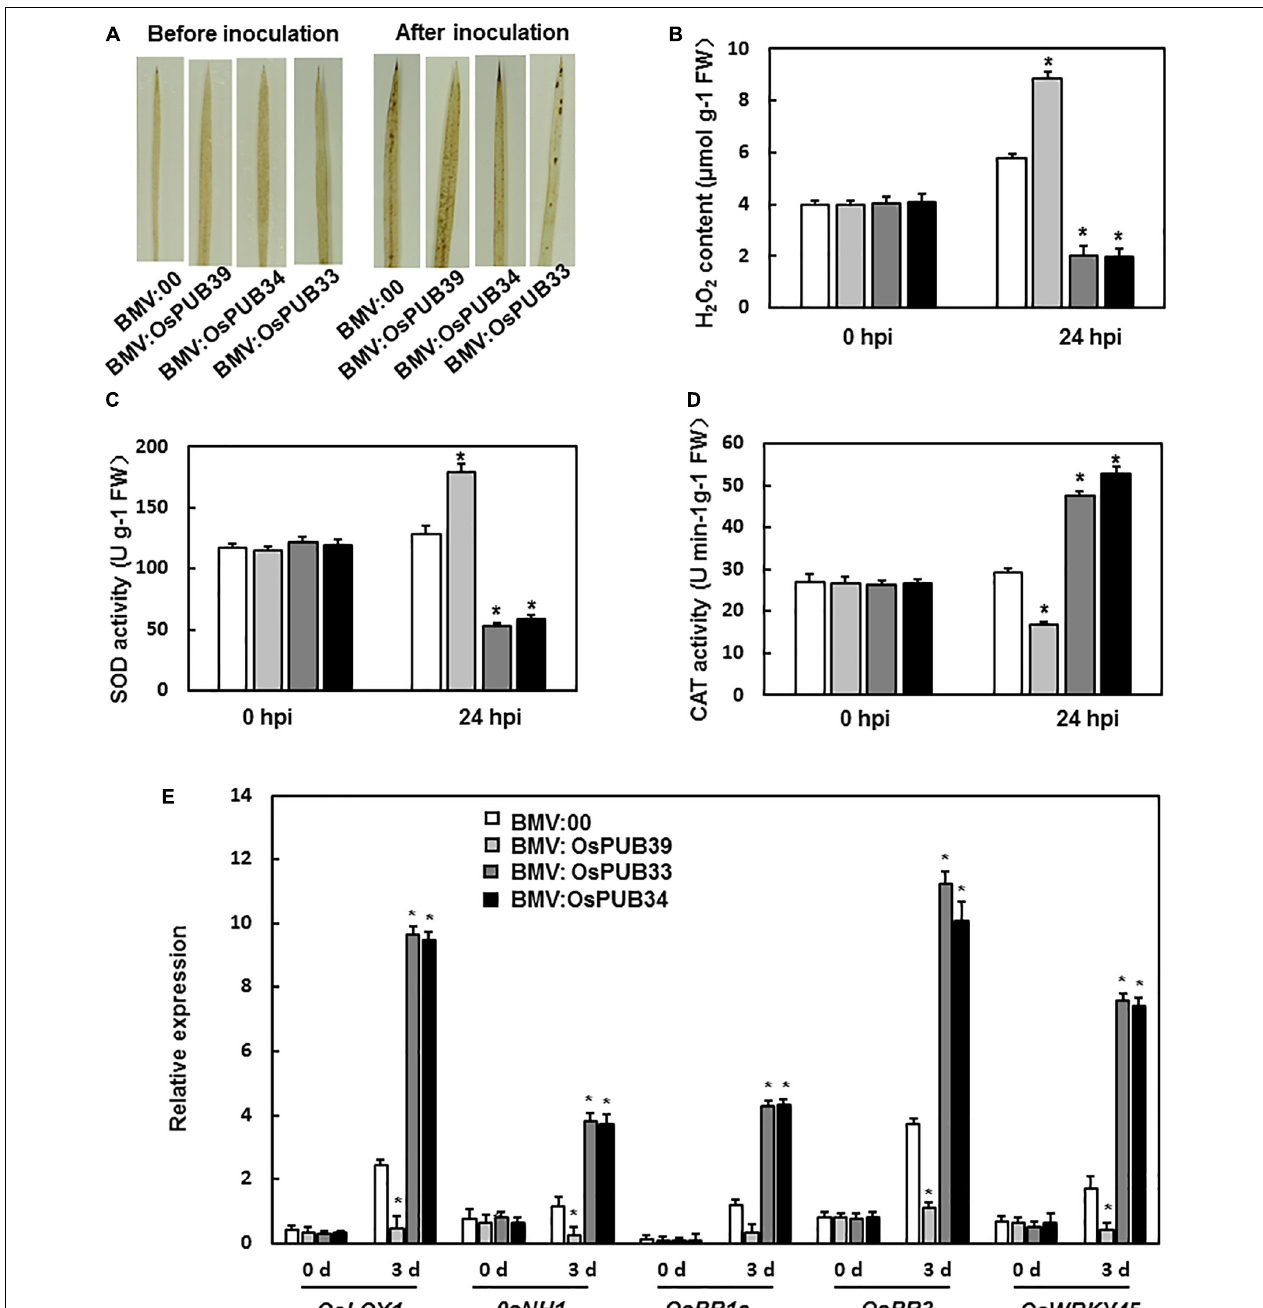
FIGURE 4 | ROS accumulation and the expression levels of defense-related genes in BMV:target gene- and BMV:00-infiltrated seedlings before and after M. oryzae inoculation. (A) DAB staining of leaves from BMV:target gene- and BMV:00-infiltrated seedlings before and after M. oryzae inoculation. (B) H 2 O 2 content in BMV:target gene- and BMV:00-infiltrated seedlings before and after M. oryzae inoculation. SOD activity (C) and CAT activity (D) in BMV:target gene- and BMV:00-infiltrated seedlings before and after M. oryzae inoculation. (E) Expression levels of defense-related genes were shown as multiples of the OsActin expression level, which was used as a standard. Data presented are the means ± SD from three independent experiments, and * above the columns indicate significant differences between BMV:target gene- and BMV:00-infiltrated seedlings at p < 0.05 level.